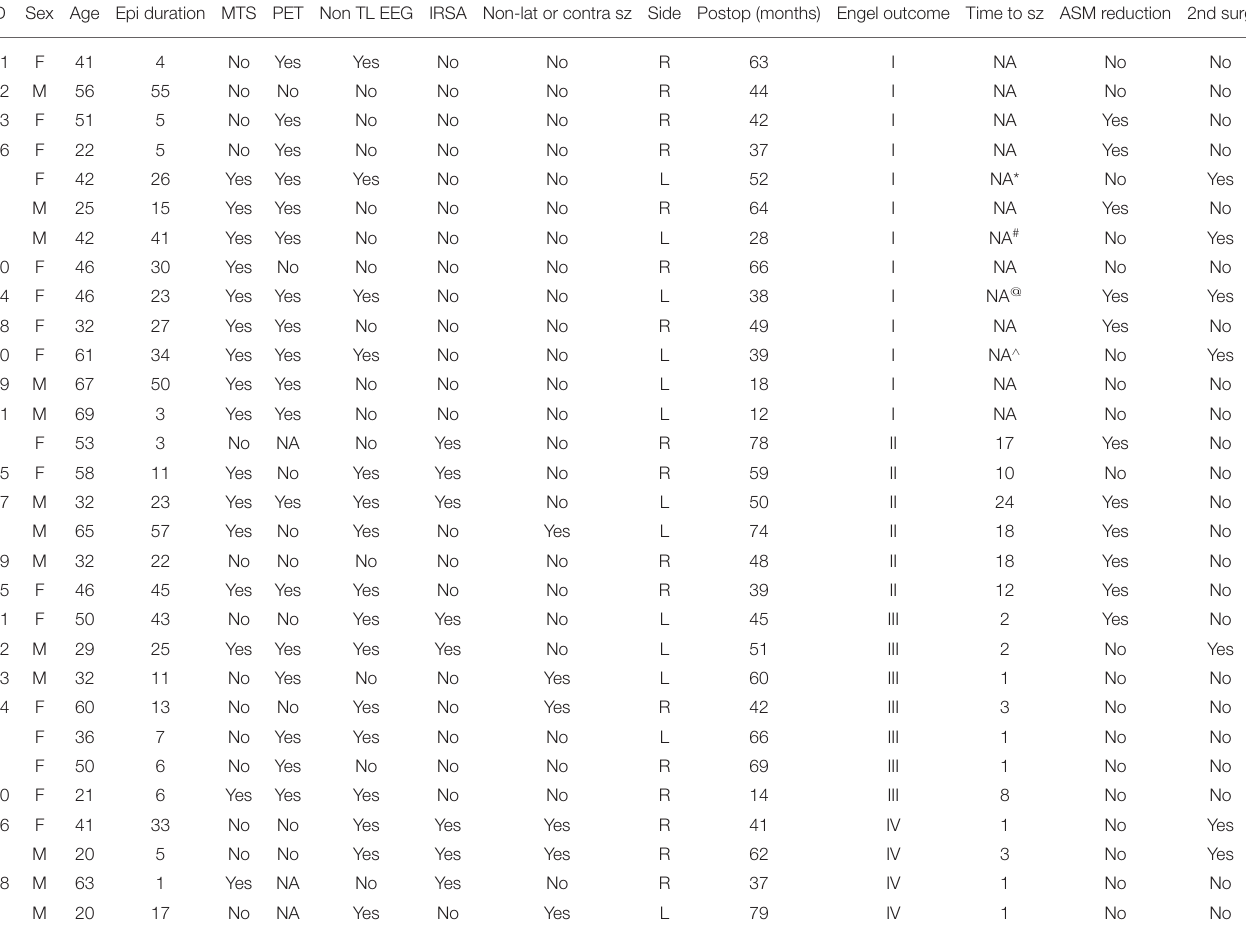
TABLE 1 | Demographic information arranged by surgical